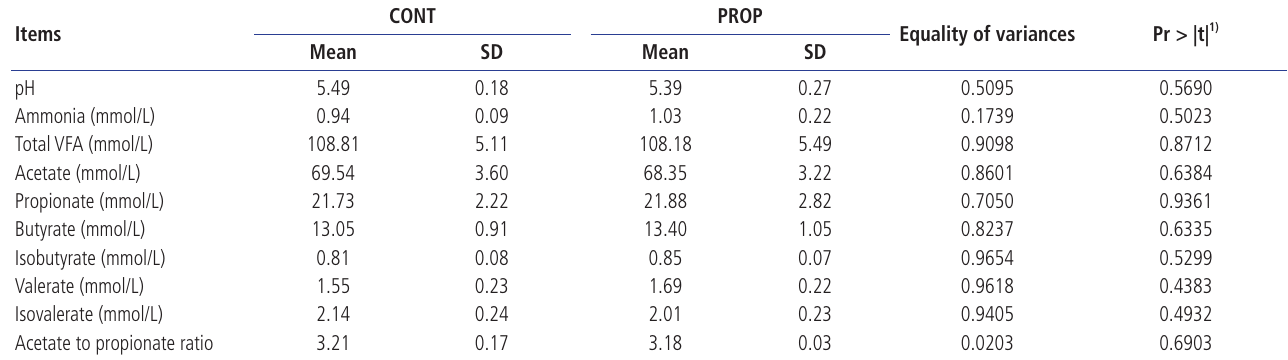
Table 1. Effect of calcium propionate feeding on ruminal fermentation